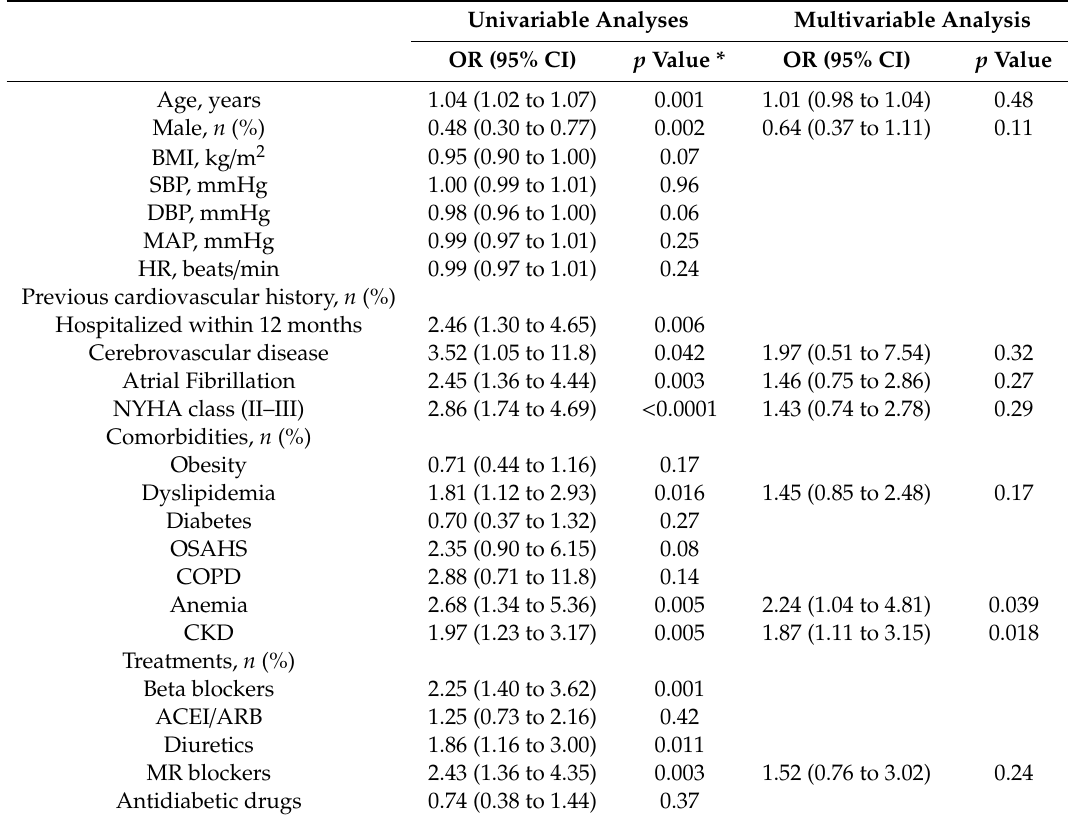
Table 2. Logistic regression analyses for the biomarker